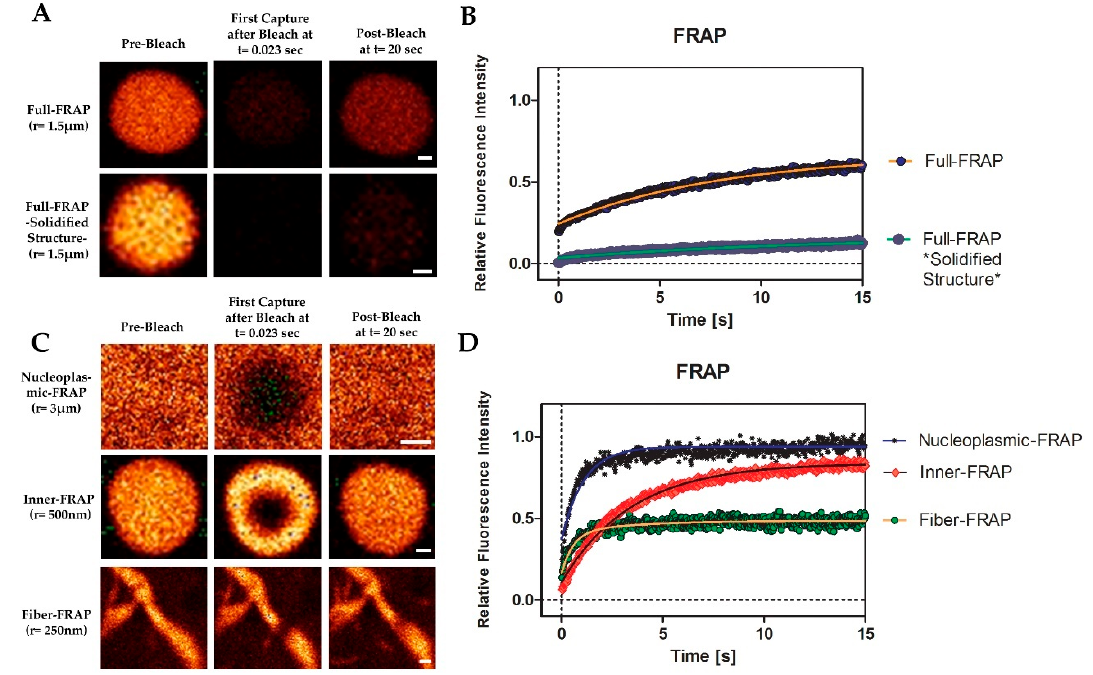
Figure 8. MRPIP nuclear condensates show dynamic liquid-like properties. ( A ) Representative images of Full-Fluorescence recovery after photobleaching (FRAP) experiments that were performed on GFP-MPRIP nuclear condensates. The lower row images correspond to a solidified structure. Imaging rate was 23 ms. Scale bars represent 0.5 µ m. ( C ) Representative images of nucleoplasmic-, inner- and fiber-FRAP. r is the radius of the circular bleached area. Scale bars represent 3 µ m, 0.5 µ m and 0.25 µ m from the top to the bottom, respectively. ( B – D ) The graphs represent the relative fluorescence values in time, starting with the first capture after bleaching. Each point corresponds to the corrected and normalized fluorescence values of the bleached areas of the FRAP experiments. The lines passing through the points are single exponential curves except for fiber-FRAP. The line for fiber-FRAP is a bi-exponential curve. The FRAP graph was created using one exemplary experiment for each FRAP experiment. “*” in subfigure B corresponds to a solidified structure.